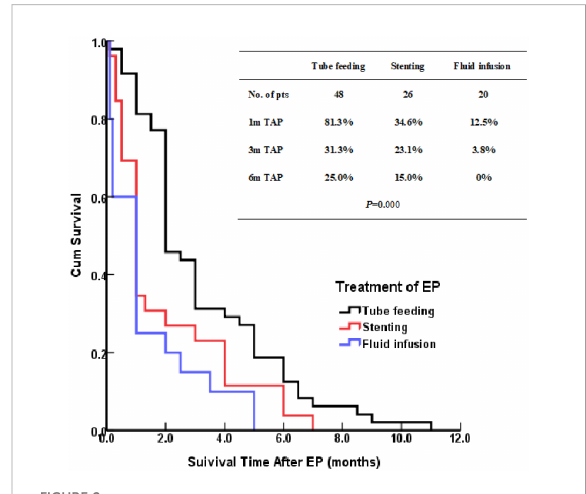
FIGURE 2 Kaplan – Meier curves for survival after